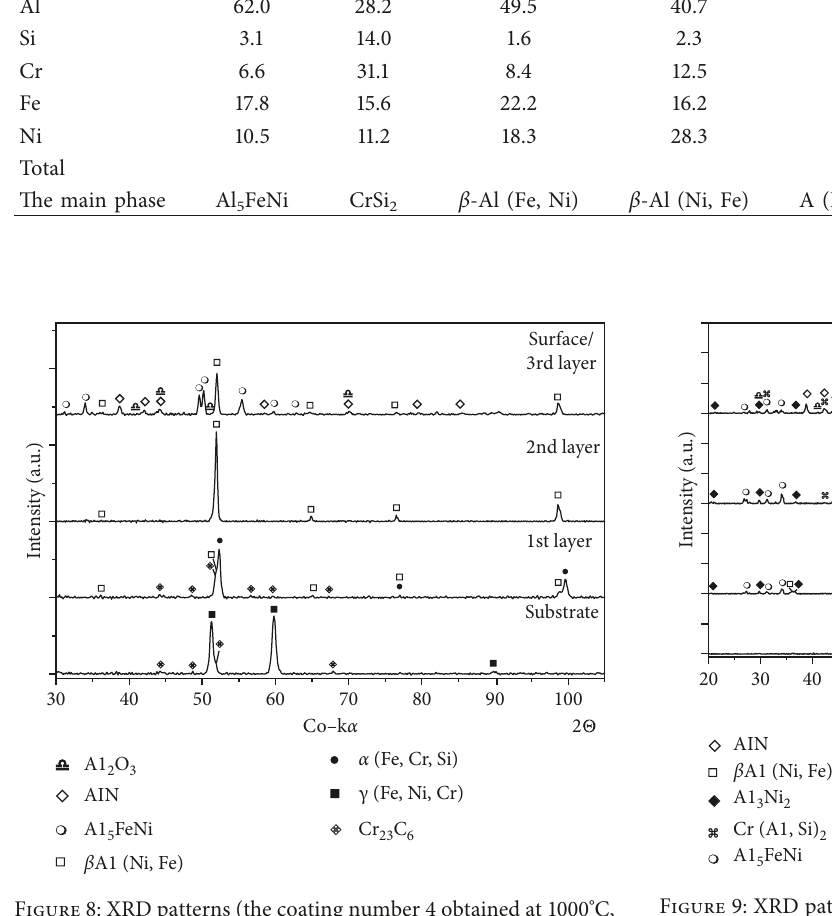
Figure 8: XRD patterns (the coating number 4 obtained at 1000 ° C, 10 hours, Al/Si 6). (cid:31)